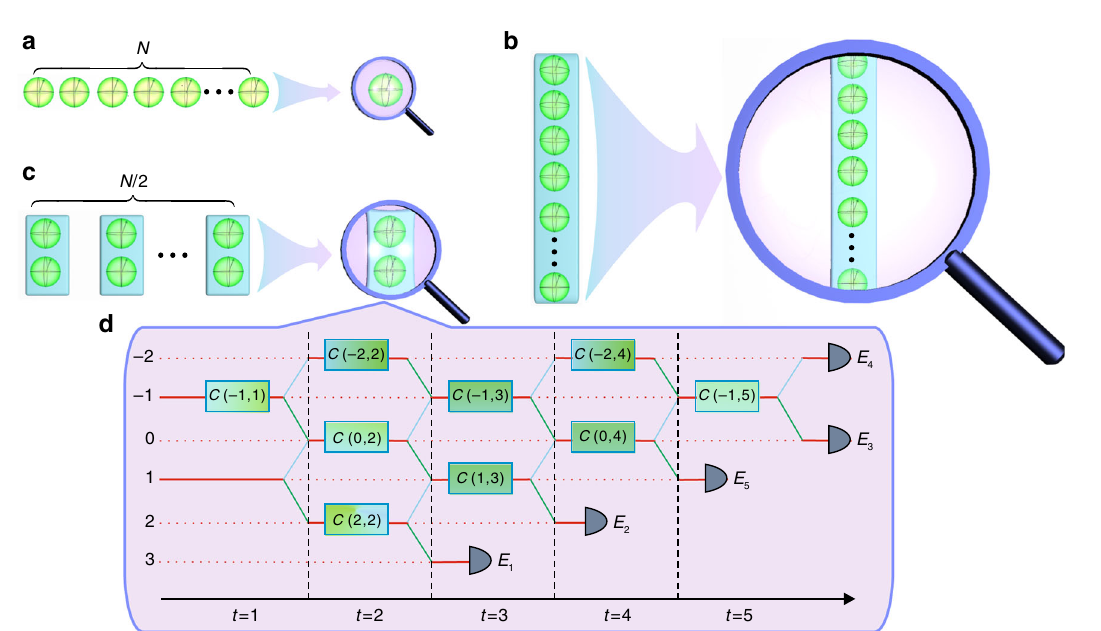
Fig. 1 Individual and collective measurements. a Repeated individual measurements. b Single N -copy collective measurement. c Repeated two-copy collective measurements. d Realization of the collective SIC-POVM de fi ned in Eqs. (1) and (2) using fi ve-step quantum walks. The coin qubit and the walker in positions 1 and − 1 are taken as the two-qubit system of interest, whereas the other positions of the walker act as an ancilla. Site-dependent coin operators C ( x , t ) are speci fi ed in the Methods section. Five detectors E 1 to E 5 correspond to the fi ve outcomes of the collective